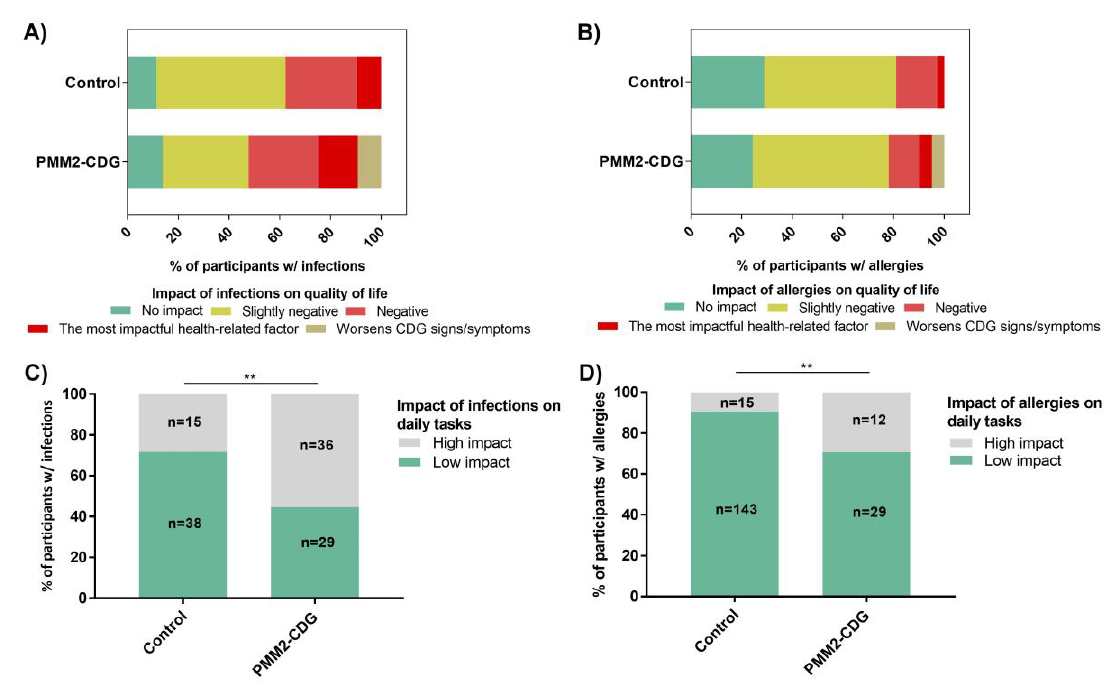
Figure 6. Infections and allergies’ impact on quality of life (QoL). ( A ) Impact of infections on general control and PMM2-CDG participants QoL; ( B ) Impact of allergies on general QoL; ( C ) Comparison of the impact of infections on everyday tasks in the control vs. PMM2-CDG. The options “No impact” and “Slightly negative” were combined forming the “Low impact” group and the same was done for “Negative” and “The most impactful health-related factor” constituting the “High impact” group. Statistical significance refers to the comparison between these two groups, the PMM2-CDG and controls ( p = 0.0049 (**)/OR = 3.11); ( D ) Comparison of the impact of allergies on everyday tasks in the control vs. PMM2-CDG. “No impact” and “Slightly negative” were combined forming the “Low impact” group and the same was done for “Negative” and “The most impactful health-related factor” constituting the “High impact” group. Statistical significance refers to the comparison between these two groups the PMM2-CDG and controls ( p = 0.0034 (**)/OR = 3.91). Statistical significance was determined using Fisher’s Exact test.